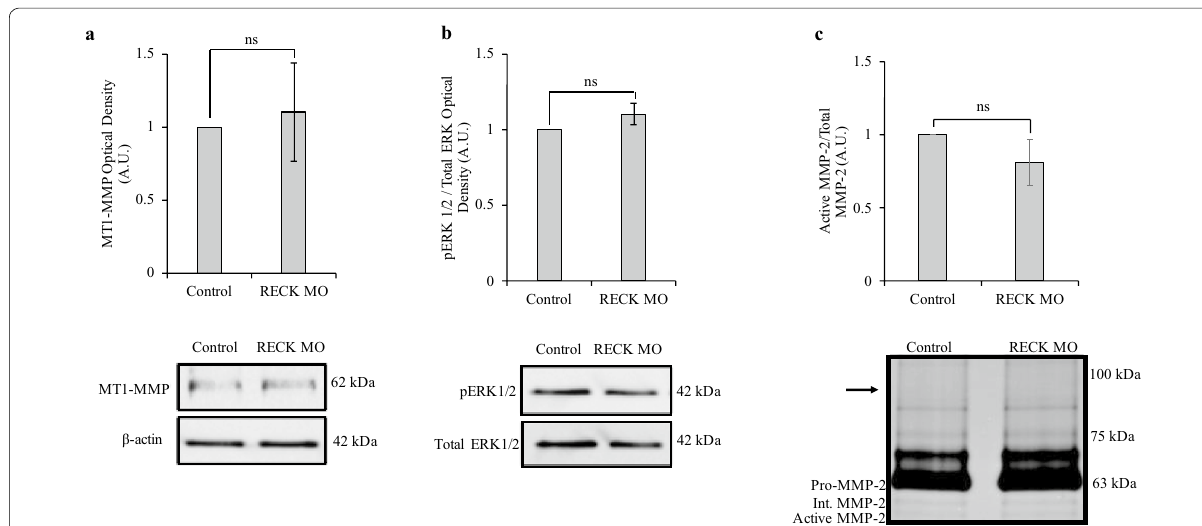
Fig. 2 RECK reduction did not alter MT1-MMP or pERK protein levels nor MMP-2 activity levels. a Densitometry quantification of MT1-MMP immunoblotted protein normalized to β-actin. MT1-MMP protein levels did not significantly change in RECK knockdown cells compared to control (set to 1). β-actin is used as a loading control. b Densitometry quantification of pERK normalized to total ERK levels. pERK protein levels did not significantly change in RECK reduced cells compared to control (set to 1). c Gelatin zymography was used to measure protein activity of secreted pro-, intermediate, and active MMP-2 following RECK knockdown in A6 cells. Data is presented as the ratio between active and total (pro-, intermediate, and active) MMP-2 levels between control and RECK reduced cells. Active/total MMP-2 levels did not significantly change in the media of RECK reduced cells compared to control (set to 1). Secreted MMP-9 protein could not be detected at the expected size of 92 kDa (shown by the arrow). Graphed data is based on 3 biological replicates (mean SD). Data is analyzed via t-test; ns, p > 0.05 ±